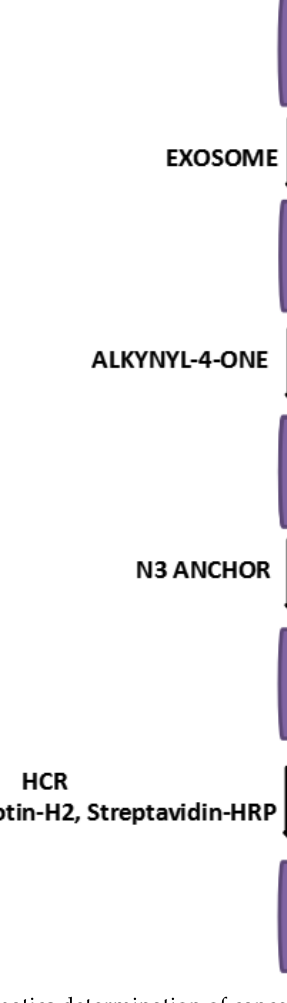
Figure 5. Schematics determination of cancer exosomes using aptasensor.